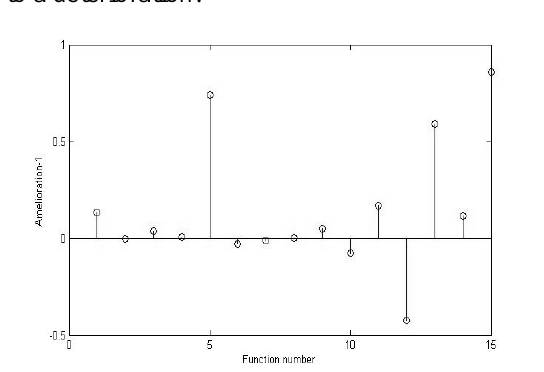
Figure 3(a). Illustration of the amelioration rate values related to BBBC for each function shifted to 0.